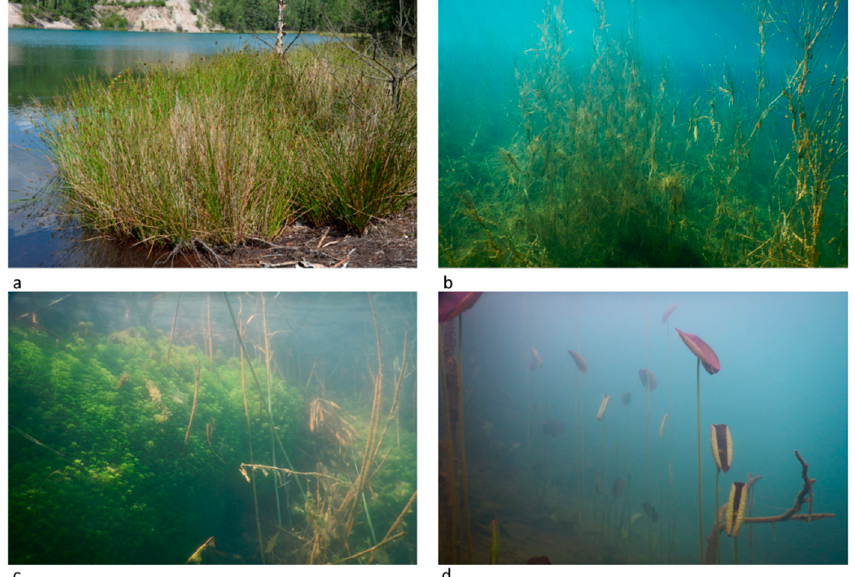
Figure 5. Examples of vegetation typical for the lakes: ( a ) Juncus effusus , ( b ) a submerged form of Juncus bulbosus , ( c ) a submerged form of Sphagnum cuspidatum , ( d) juveniles of Nymphaea alba .